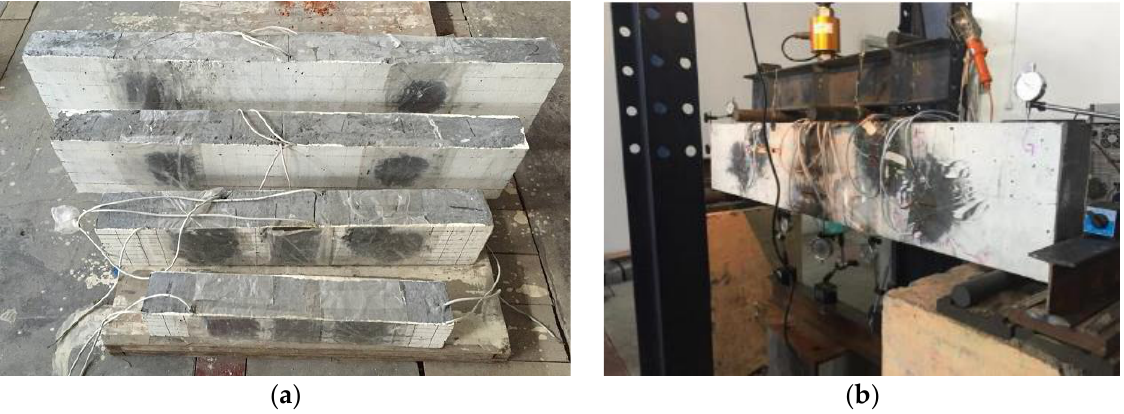
Figure 2. Beam specimens and the loading equipment. ( a ) Beam specimens with different sizes. ( b ) Loading equipment of four-bending test.